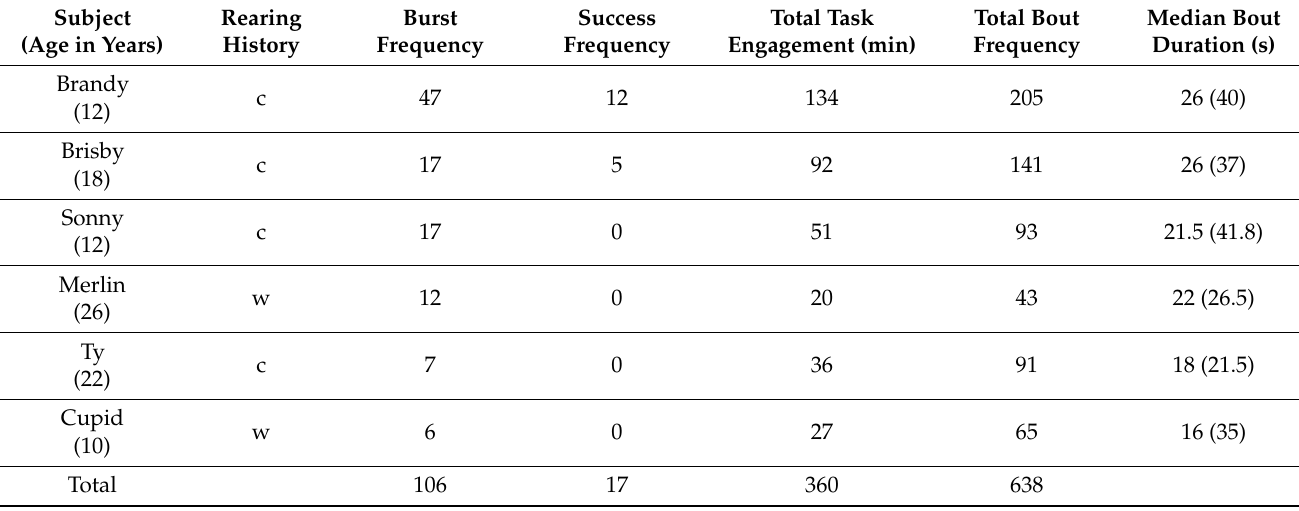
Table 2. Summary of burst production and task engagement by six male bottlenose